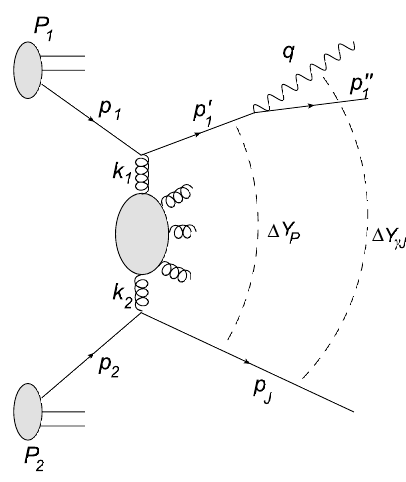
Figure 1 . One of the two diagrams for the forward Drell-Yan + backward jet production with the indicated kinematic variables. Only photon q and jet p J momenta are measured. Parton p 2 might be either quark or gluon. In the second diagram photon is emitted from the p 1 fermionic